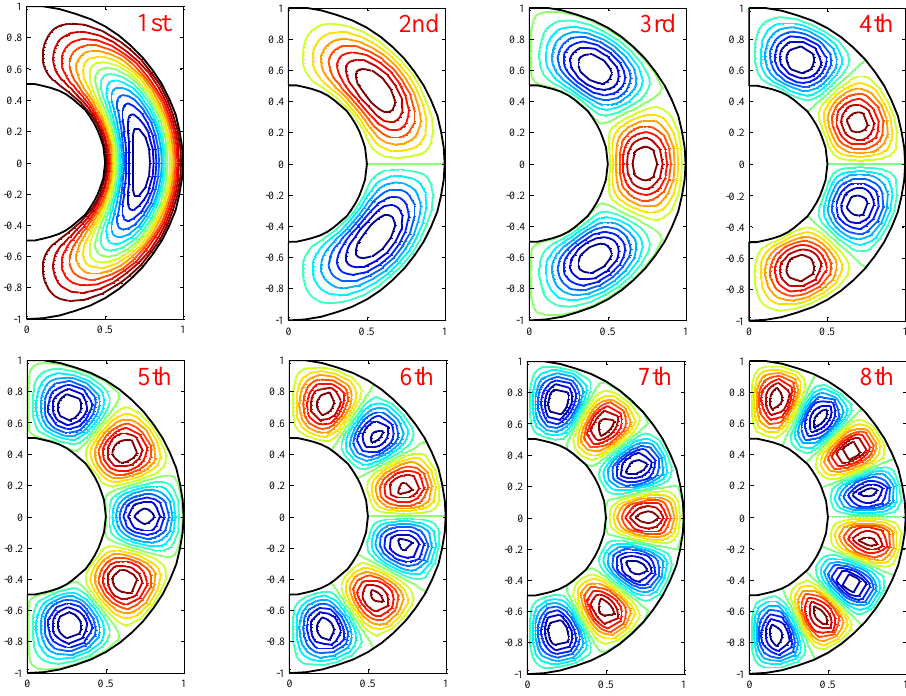
Figure 7: The lowest eight mode shapes for a [0 ∘ /90 ∘ /90 ∘ /0 ∘ ] laminated annular sector plate with E 3 E 3 E 3 E 3 boundary conditions( E 1 / E 2 =15, a / b =0.5, h / b =0.1, ϕ = π )